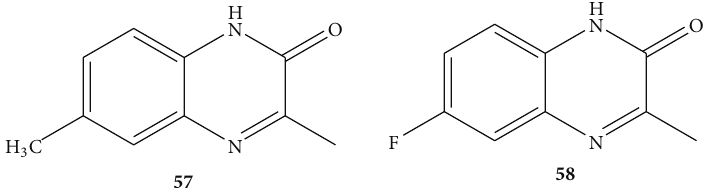
Figure 23: Chemical structures of compounds 57 and 58 .